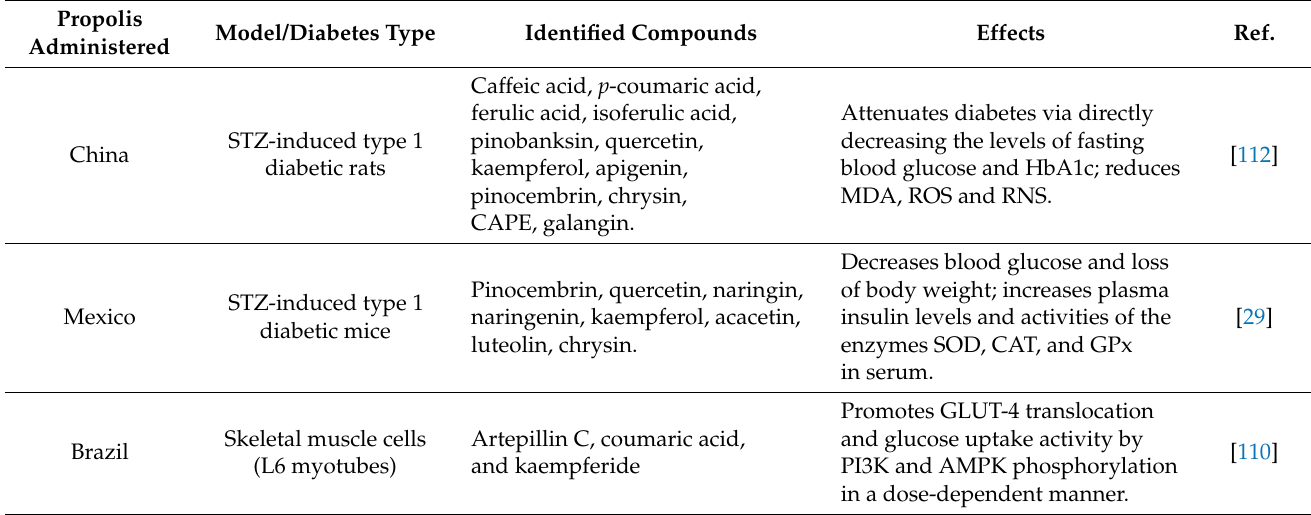
Table 3. Effect of propolis on diabetes and its main identified